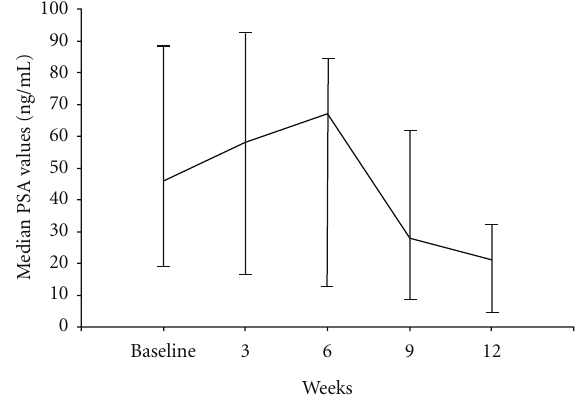
Table 4: Number of patients experiencing the most frequent treatment-related adverse events. Figure 1: Median PSA (with minimum and maximum values) in 18 out of 27 responding patients who showed a PSA surge within the first 3 months of treatment with weekly D + biweekly